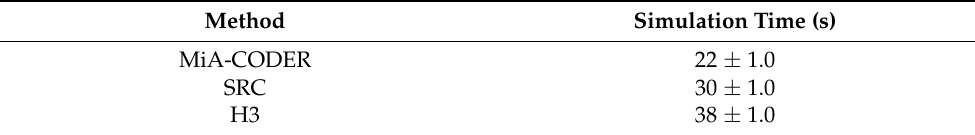
Figure 7. Simulation time vs. number of dead nodes. Table 7. Number of dead nodes analysis.